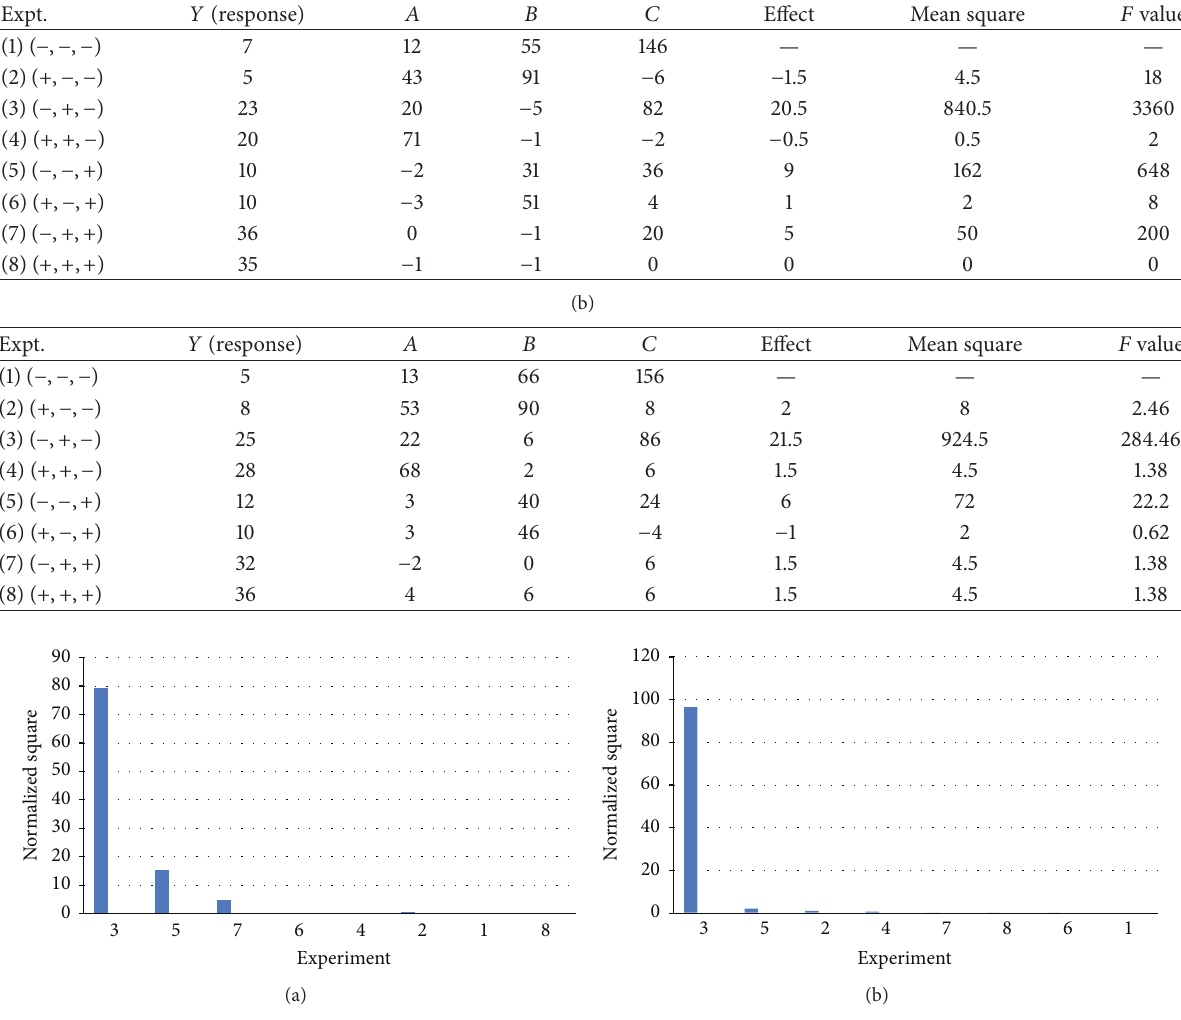
Figure 3: (a) Pareto chart for acid degradation. (b) Pareto chart for alkali